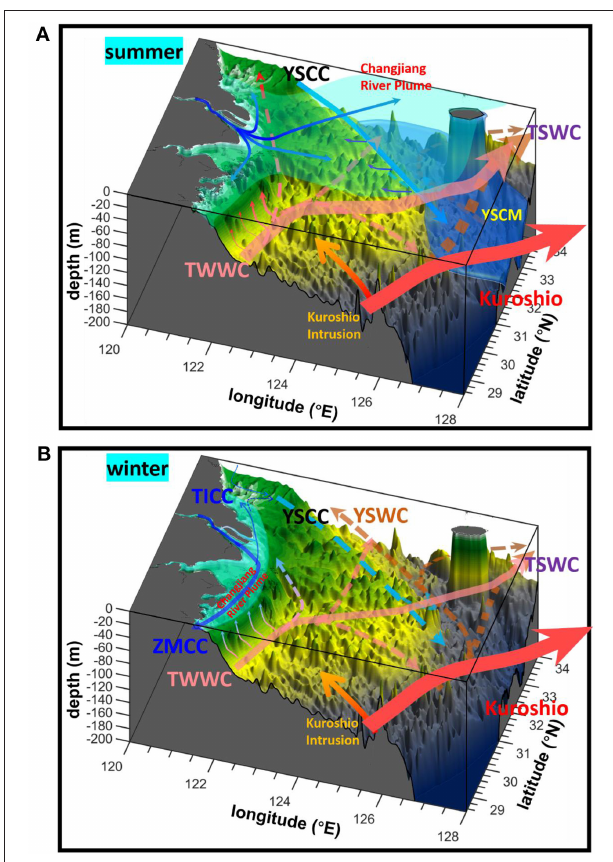
FIGURE 7 | Schematic of general circulations around the Changjiang Estuary in (A) summer and (B) winter. The shelf currents over the ECS are indicated by the vectors with warm colors, and the buoyant plume, TICC and YSCC are shown by the cold colors. The dashed lines indicate uncertainty in observed pathway of circulations in the ECS and southern